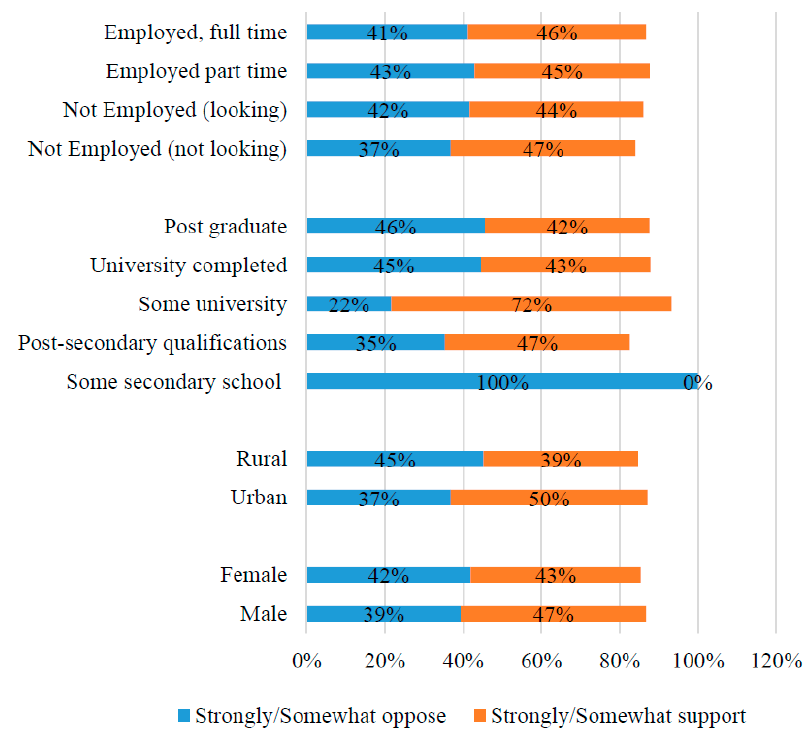
Figure 4. Support for taxes/fees by sociodemographic factors; Source: Author’s construct.